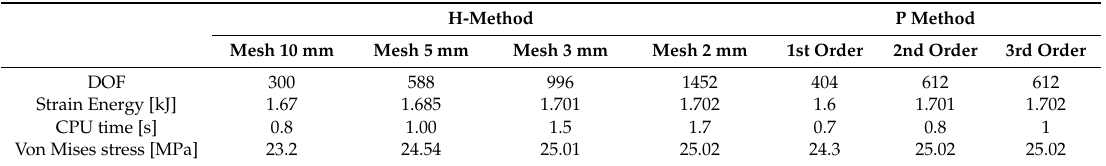
Table 3. Comparison between two numerical approaches, H and P methods, regarding the degree of freedom, strain energy and CPU time for a single unit